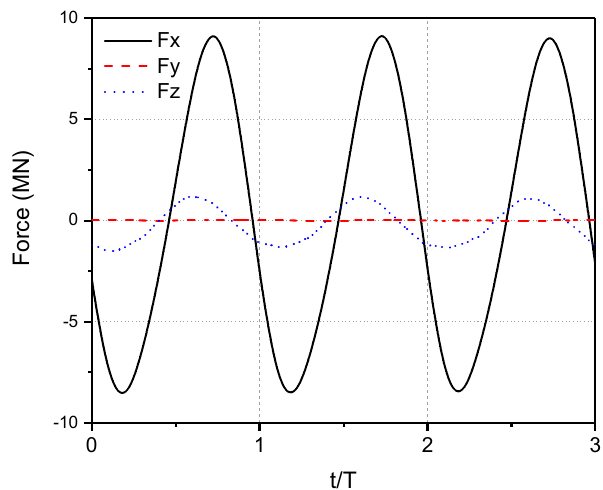
Figure 10. Force comparison in x , y , z directions for a fixed semi-submersible platform to regular wave ( H = 6.0 m, T = 15.0 s).